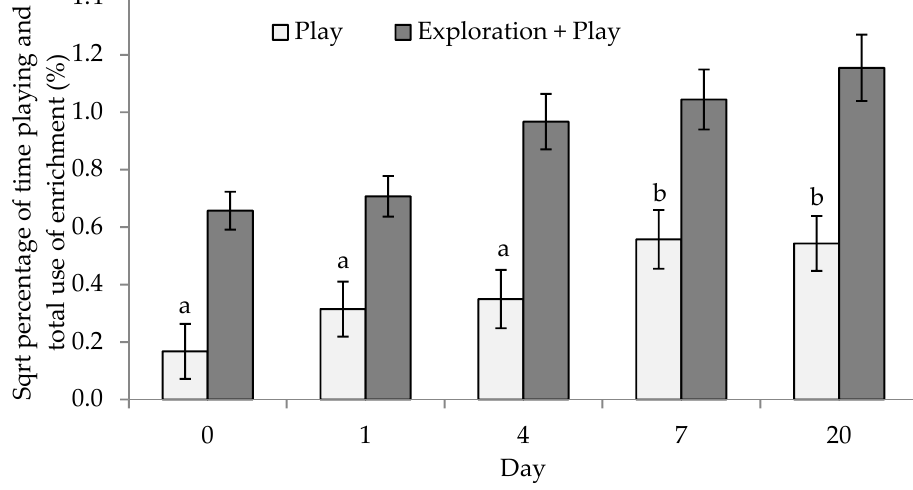
Figure 2. The effect of housing on mean ± SEM (standard error of the mean) percent of total time in play and the total time using the materials (play + exploration; over 6 h, from 0700 hours) in enhanced housing (hanging mats, ropes and yellow disks), of group housed sows following mixing (d0) in (significant differences are indicated by different superscripts, play; a, b p < 0.001, total material use (play + exploration) p > 0.05).